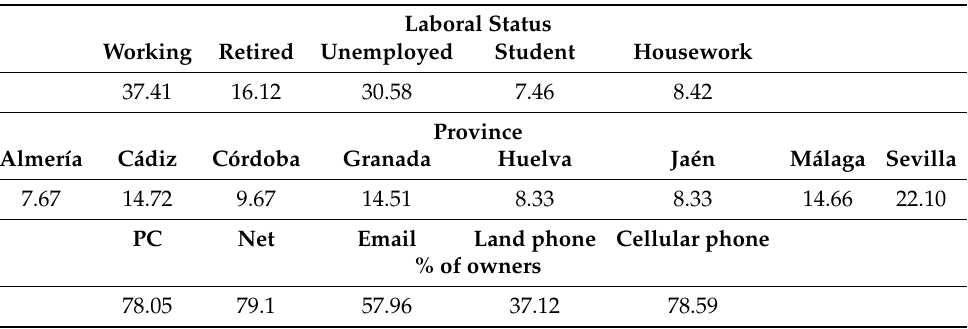
Table 5. Auxiliary variables at panel level